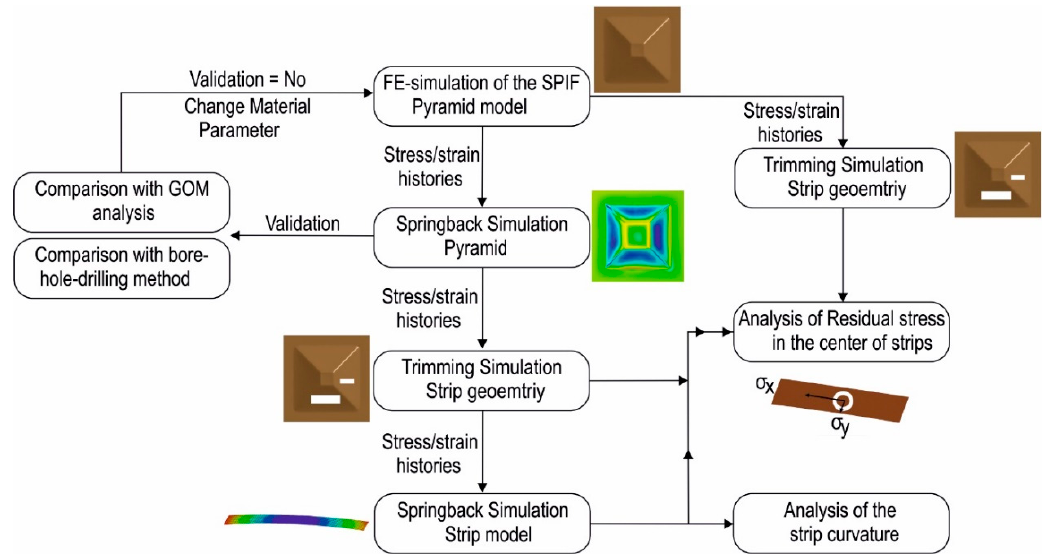
Figure 6. A flow chart describing the procedure adopted to achieve the objectives of the study.